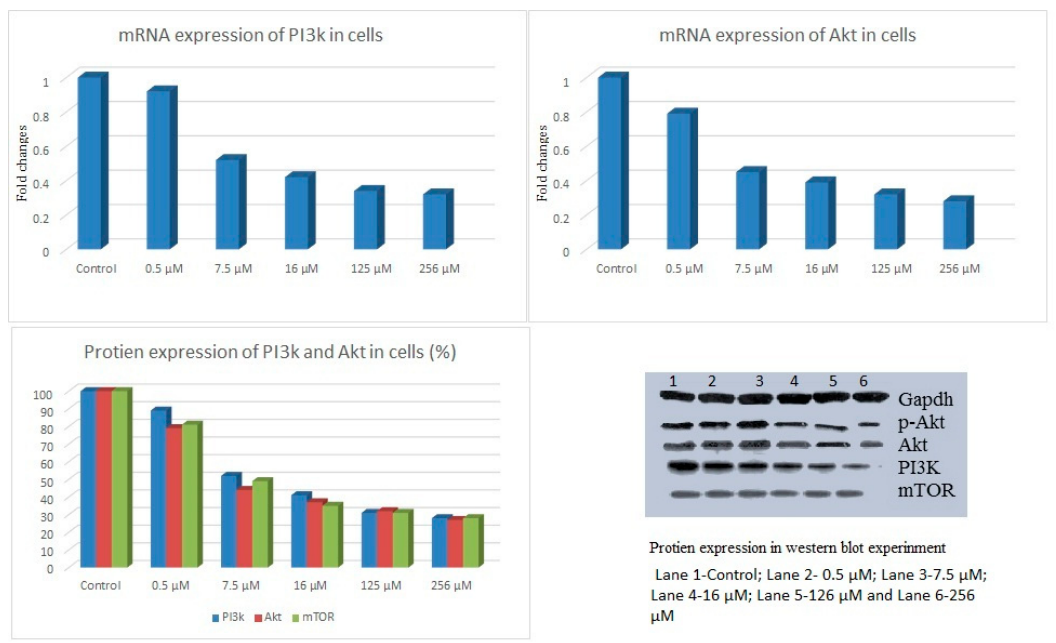
Figure 7. E ff ect of Ag-MC on mRNA and protein expression of MAPK signaling